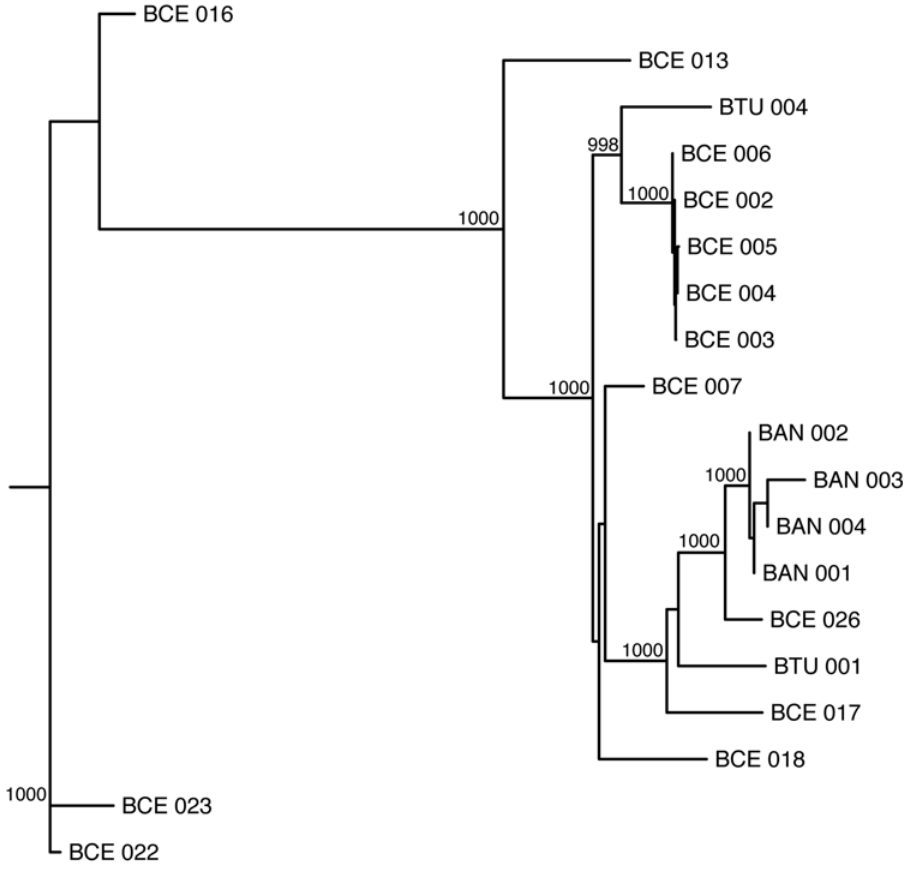
Figure 5. Neighbor-joining phylogenetic tree inferred using resequencing array (RA) data with a quality score threshold of 30 for a subsample of 19 Bacillus strains. Bootstrap values for nodes with greater than 99% support (1000 replicates total) are shown.